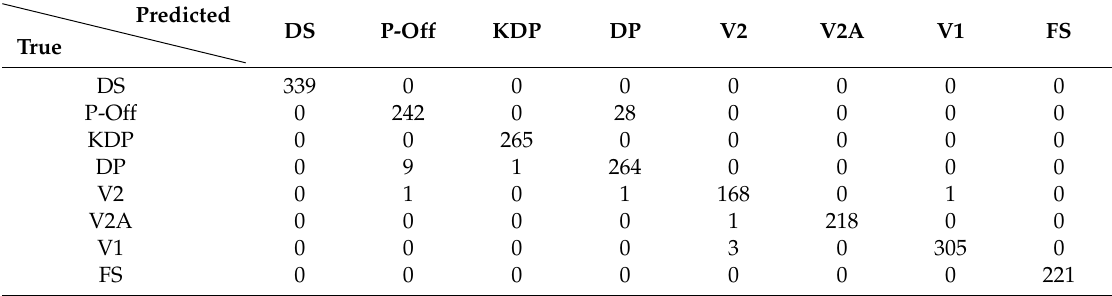
Table 9. Confusion matrix for the training dataset for the sports biomechanics configuration of sensors.